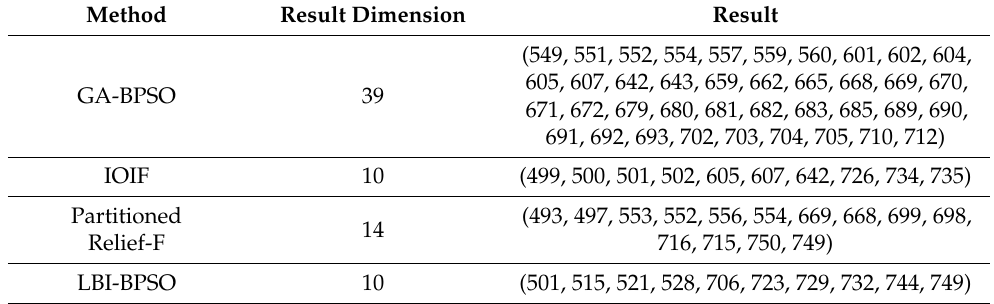
Table 2. Dimensionality reduction